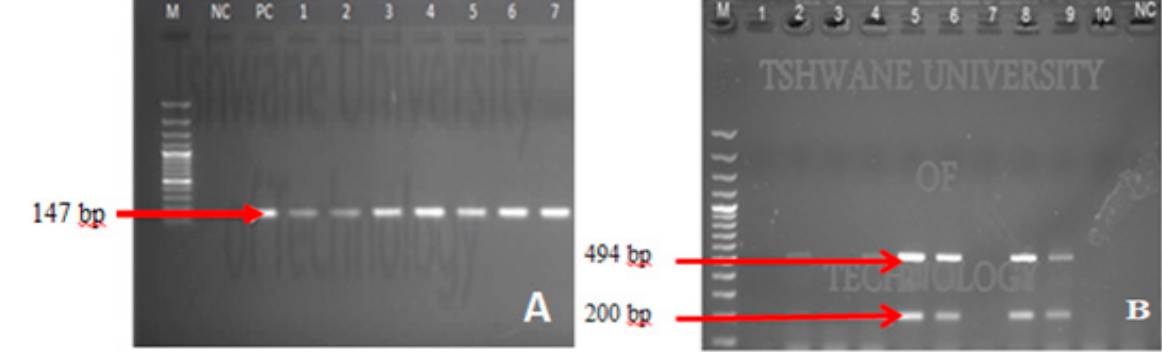
Figure 6. Gel electrophoresis of confirmed enteropathogenic bacteria; Figure 6A shows an agarose gel picture of results obtained from conventional PCR in detection of uidA gene for E. coli (147 bp) while Figure 6B shows an agarose gel picture of results obtained from multiplex PCR in detection of ipaB (494 bp) and ipaH (200 bp) genes for Salmonella spp. and Shigella spp., respectively. M: Molecular Marker ( A : 100 bp and B : 1 kb); Lane 1–10 test organism; NC: Negative Control; PC: Positive Control.